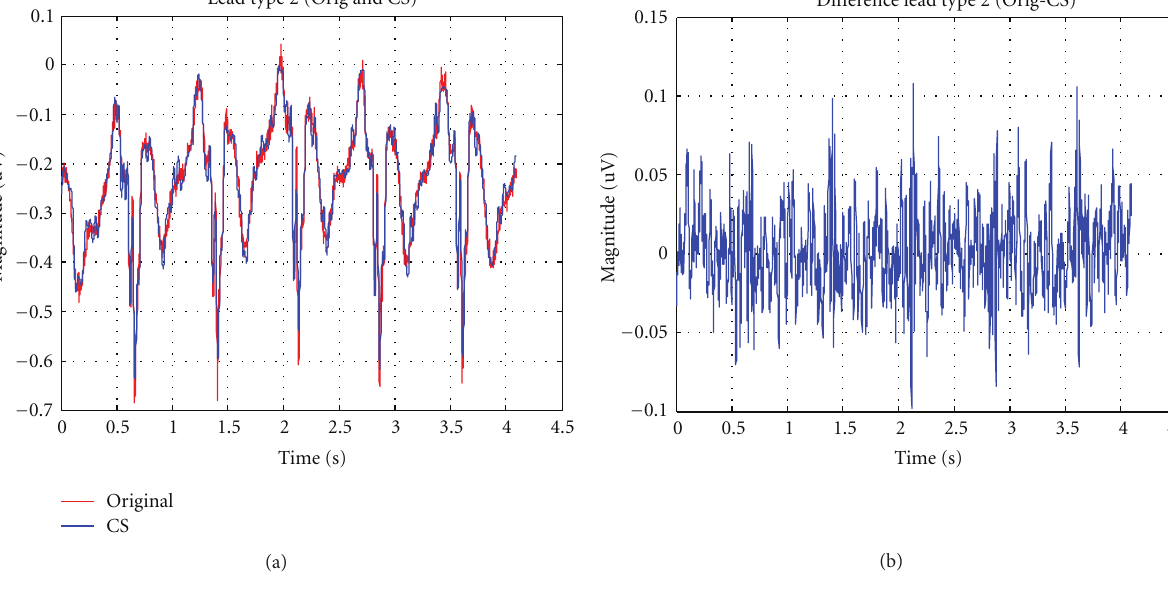
We take Block Sparse Compressive Sensing Code published by Rice University Baranuik et al. 2008